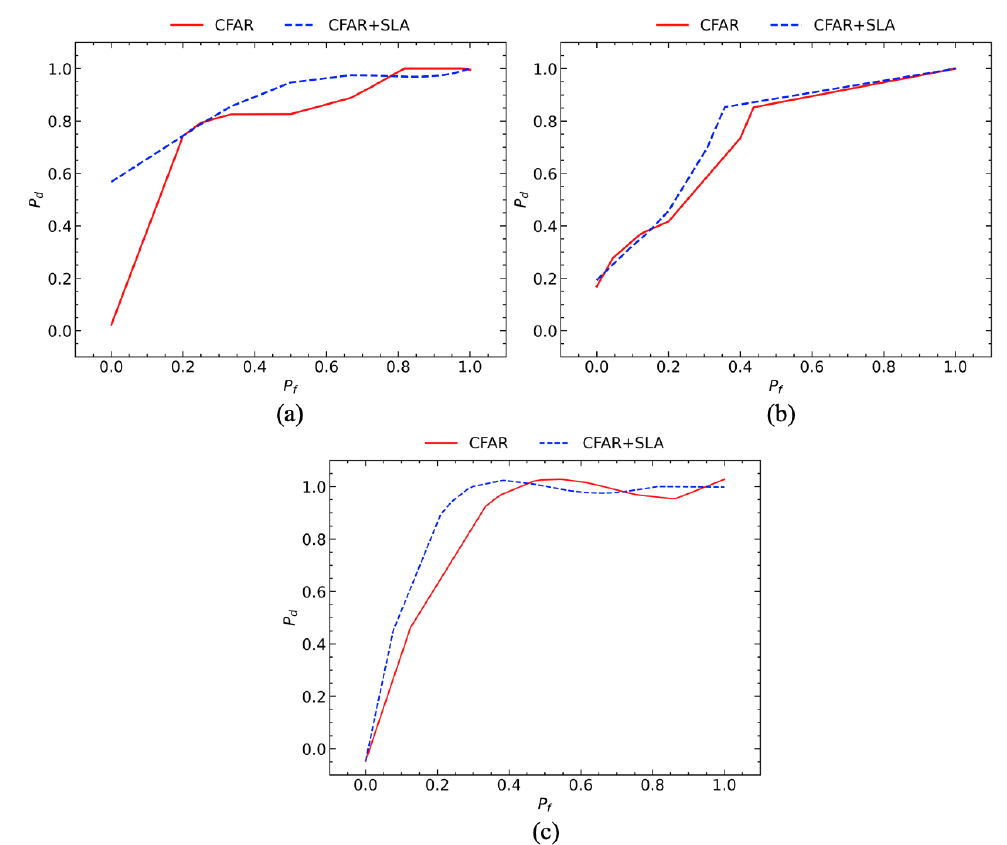
Figure 12. ROC evaluation of Cosmo-SkyMed (108 targets labeled) ( a ), SAOCOM (113 targets labeled) ( b ), and Sentinel-1 (331 targets labeled) ( c ) products in the Adriatic region.